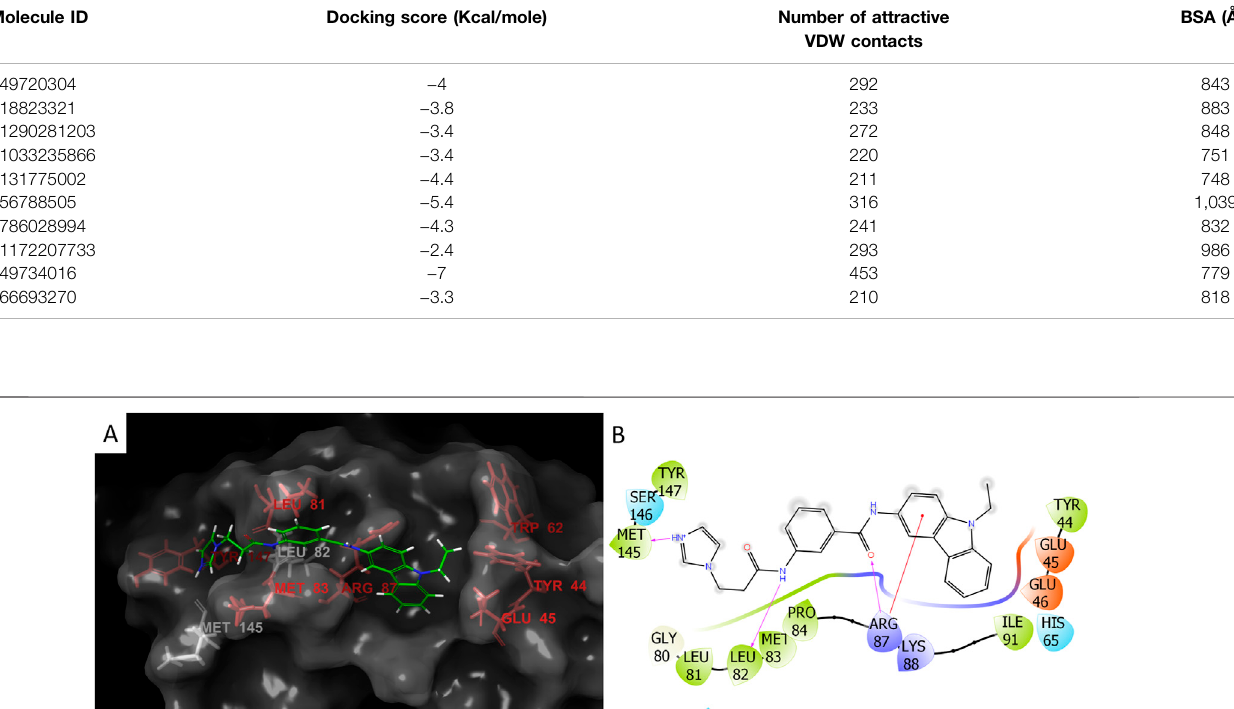
Frontiers in Cell and Developmental Biology |